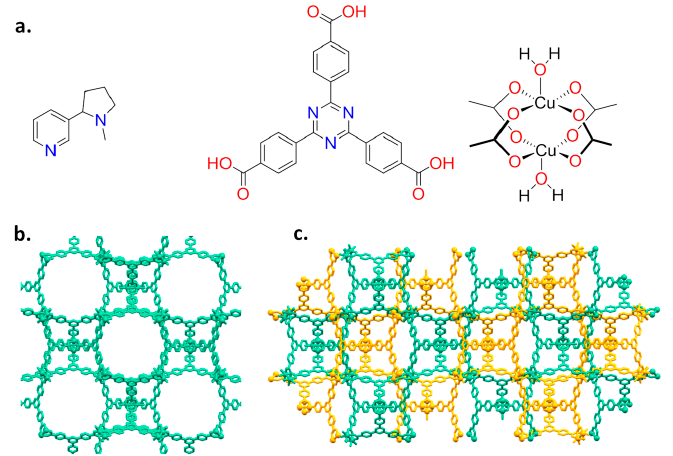
Figure 1. ( a ) Molecular structures of nicotine (left), TATB ligand (middle) and Cu paddle-wheel (right); and ( b , c ) the two isoreticular isomeric networks PCN-6 ′ and PCN-6. In PCN-6 the two interpenetrated frameworks are in different colours.